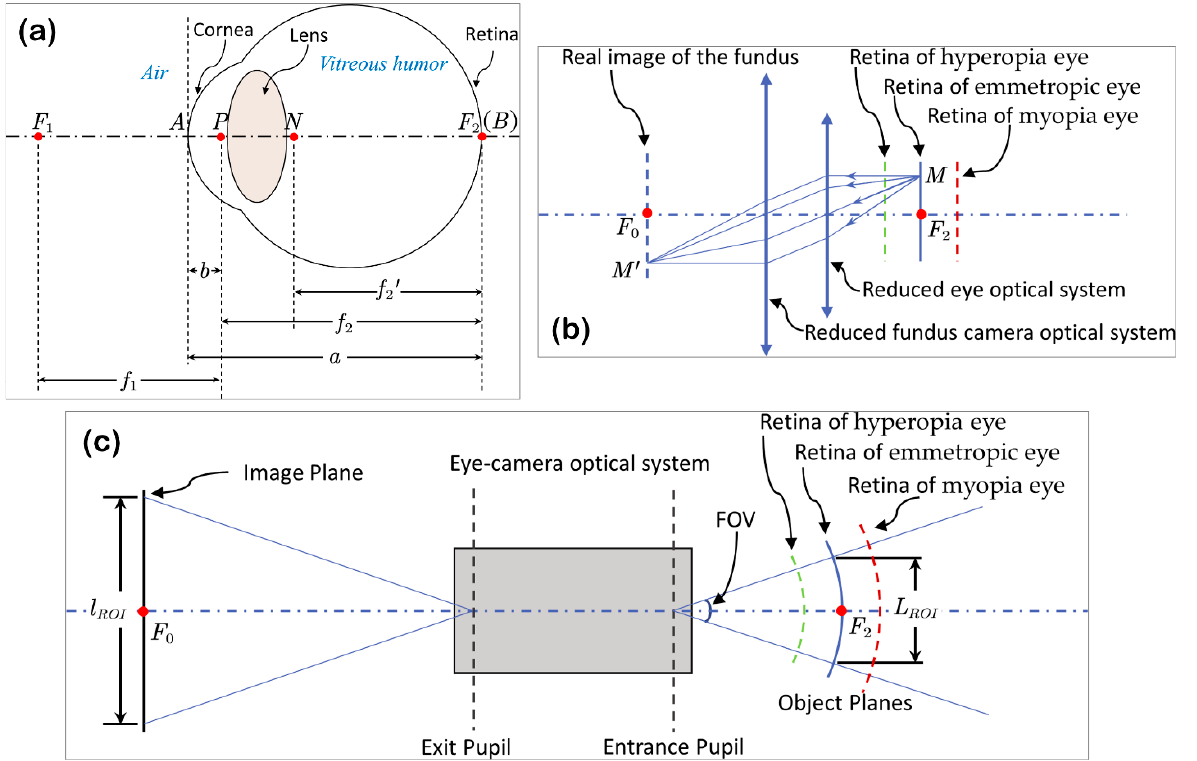
Figure 1. Geometric bases of the eye and the fundus camera model. ( a ) shows the reduced emmetropic eye model, ( b ) shows simplified optical process of fundus camera, and ( c ) shows the geometric model of the FOV of a fundus camera.